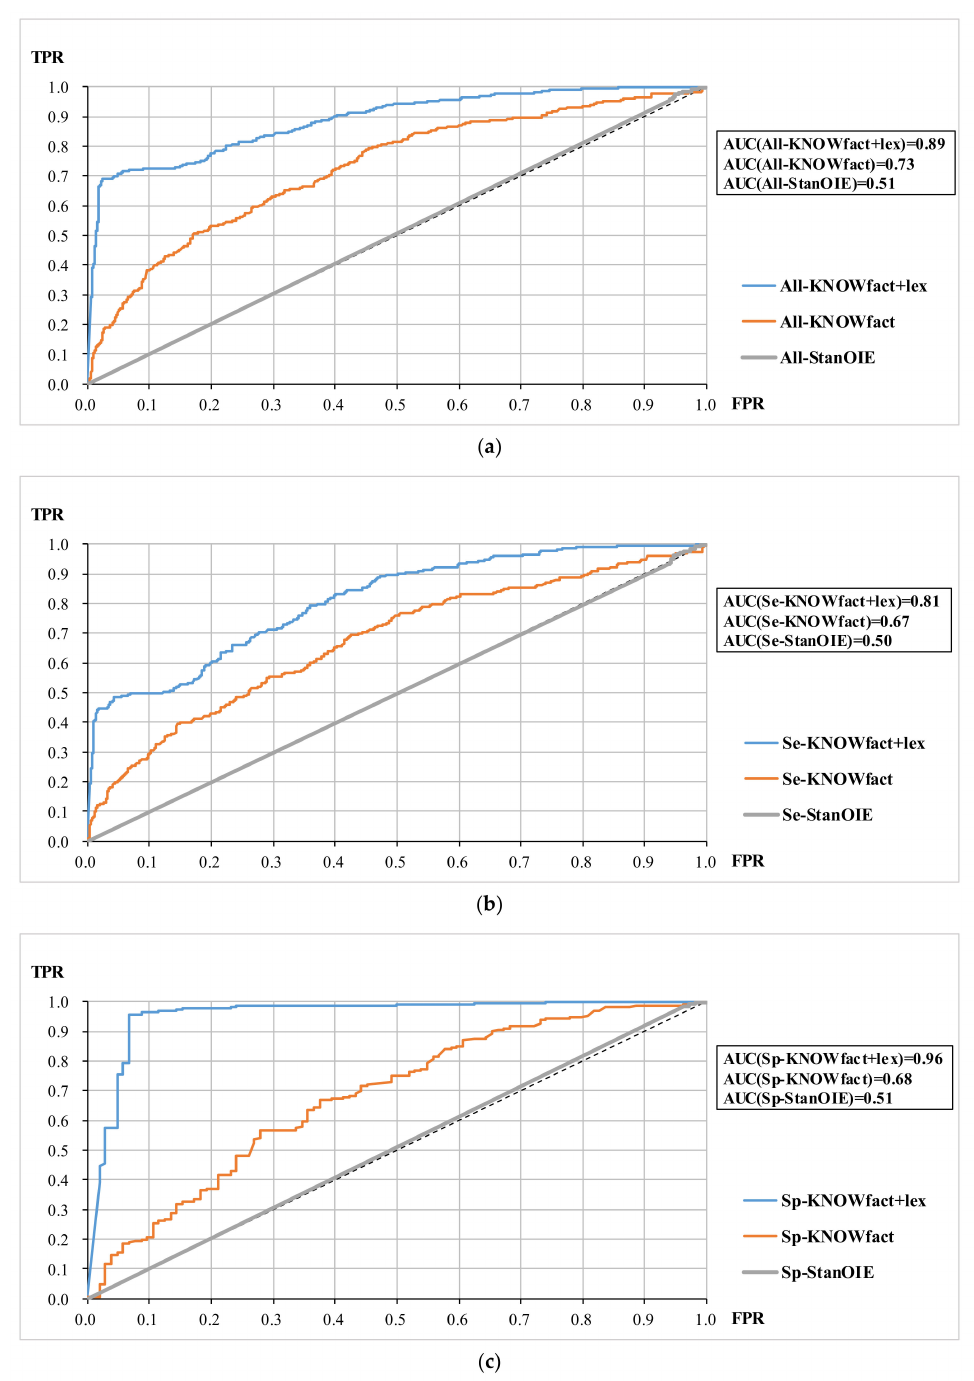
Figure 4. ( a ) ROC and AUC for all samples; ( b ) ROC and AUC for semantic relation samples; ( c ) ROC and AUC for spatial relation